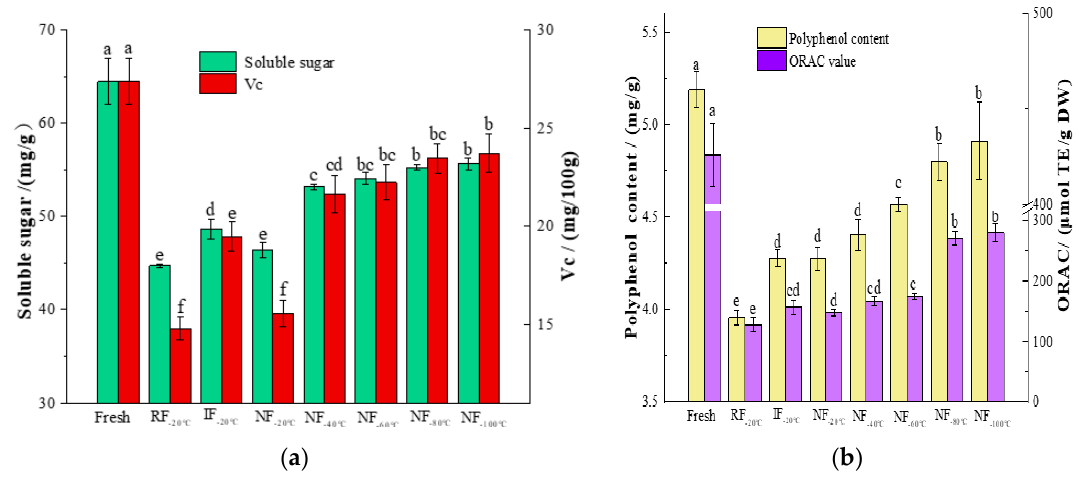
Figure 3. E ff ects of di ff erent freezing process on the contents of the bioactive compounds of blueberry: ( a ) soluble sugar and Vc; ( b ) polyphenol and ORAC.